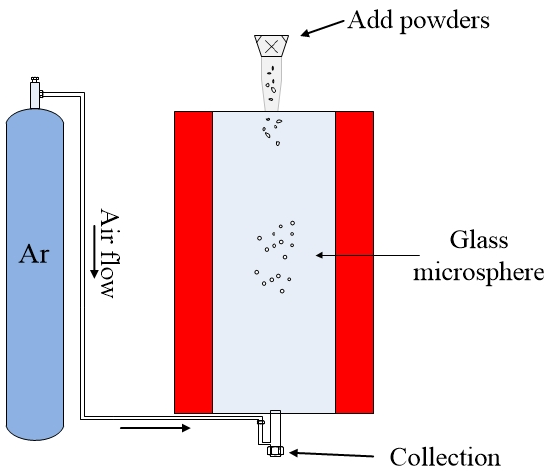
Figure 7. Schematic diagram of fabrication of microsphere by powder floating method.